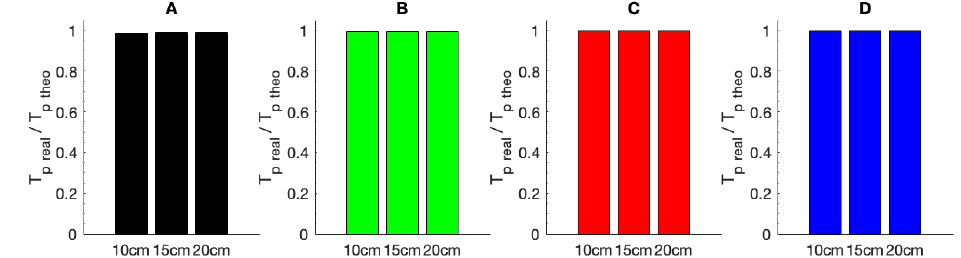
Figure 13. Ratio of realised ( T p T p = 2.58 s, H s = 10 cm, 15 cm, and 20 cm sea-states for facilities ( A – D ).